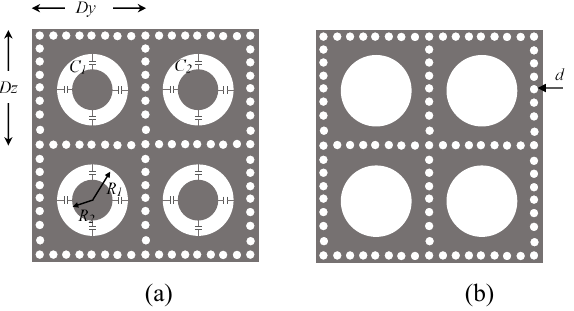
Figure 3. Arrangement of basic FSS elements: (a). Front view, (b) Back view